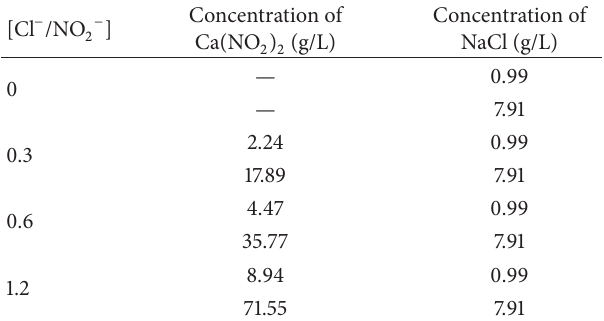
Table 1: Details about the composition of studied